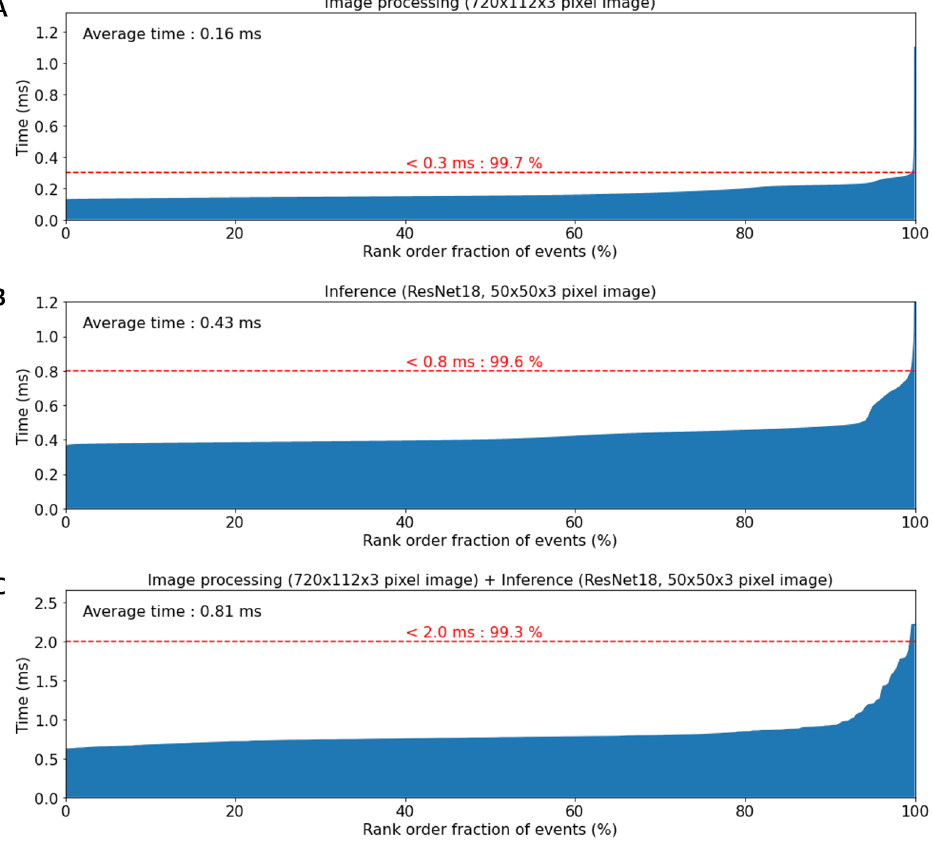
Figure 3. Plots of computation time. ( A ) Image processing time without image classification. The average time of image processing is 0.16 ms. ( B ) The inference time on ResNet18 with 50 × 50 × 3-pixel images. The average time of image classification is 0.43 ms. ( C ) The total processing time. The graph indicates that 99.3% of total processing was completed within 2.0